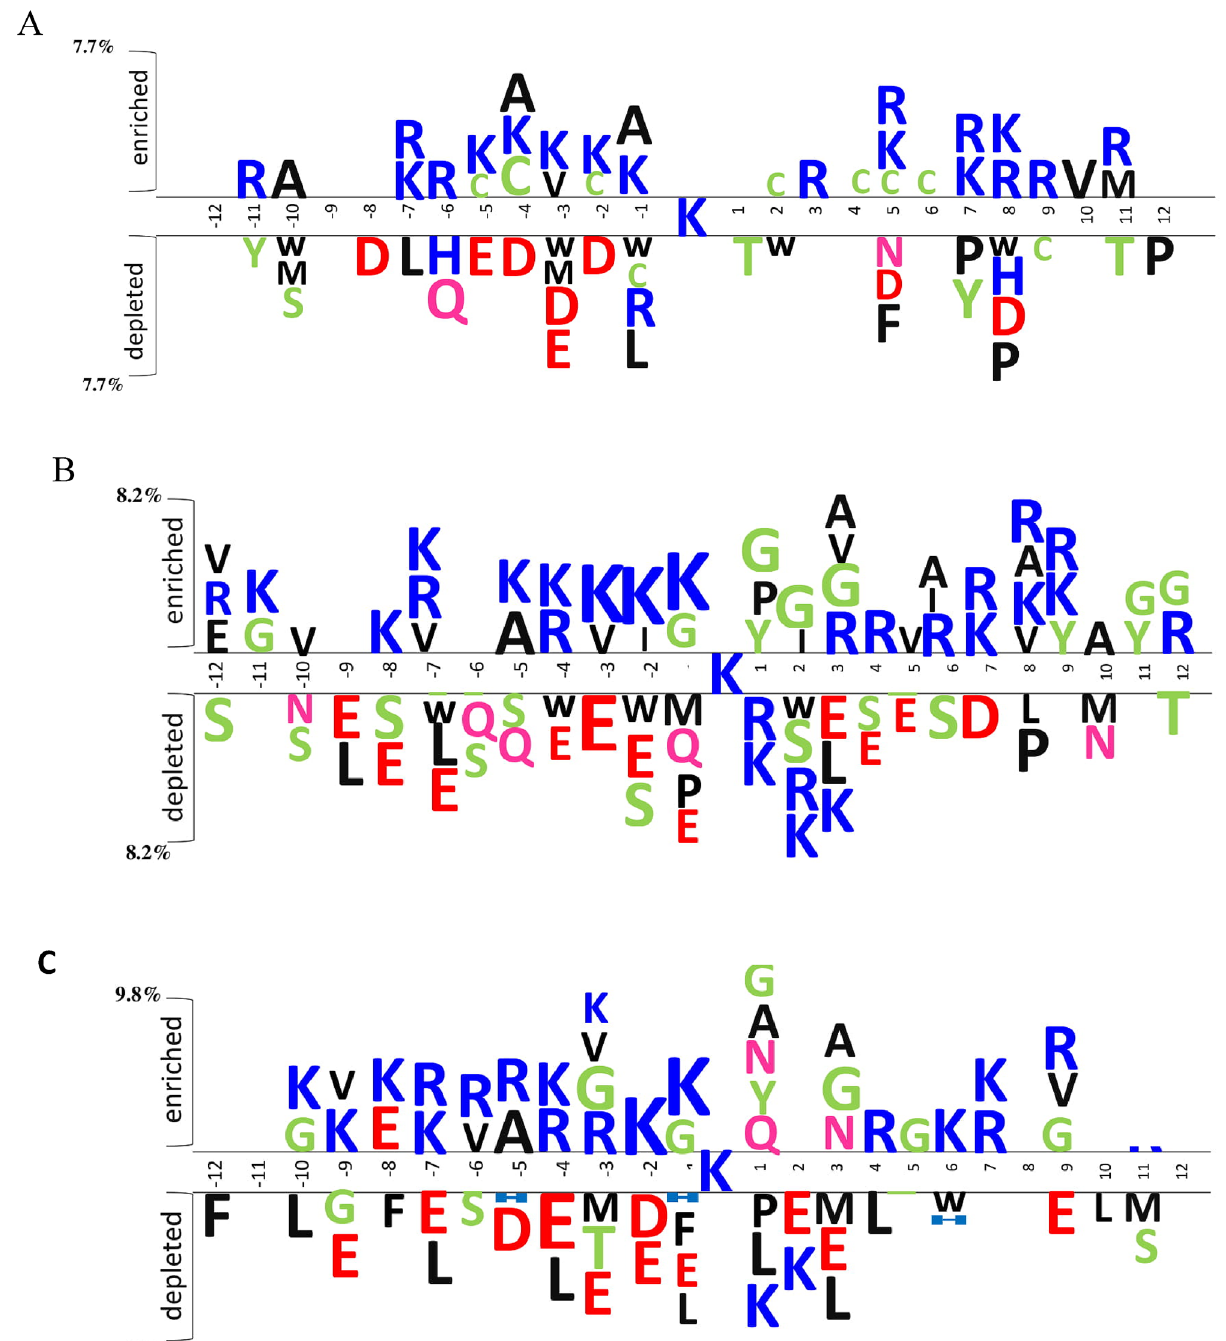
Figure 3. The distribution of amino acids around the central lysine in ( A ) E. coli , ( B ) H. sapiens and ( C ), and M. musculus